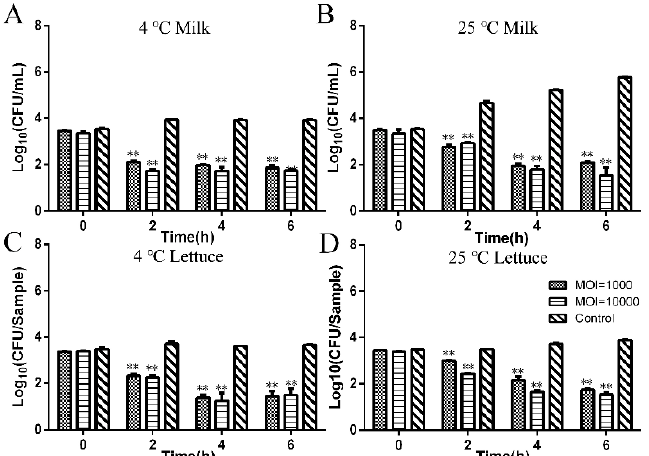
Figure 3. Application of LPSEYT in milk and on lettuce. Phage suspension was added into milk and onto the lettuce at an MOI of 1000 and 10,000. ( A ) LPSEYT applied in milk at 4 ◦ C. ( B ) LPSEYT applied in milk at 25 ◦ C. ( C ) LPSEYT applied on lettuce at 4 ◦ C. ( D ) LPSEYT applied on lettuce at 25 ◦ C. Data are shown as mean ± SD.